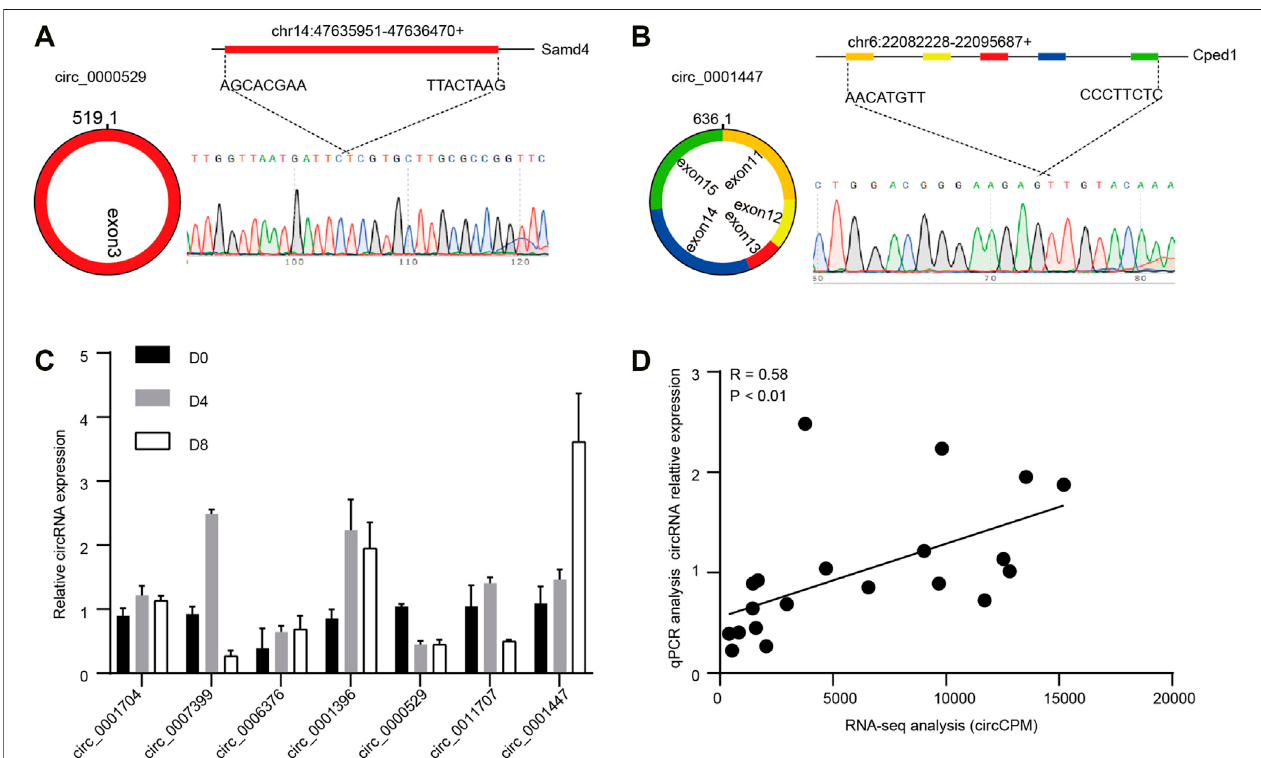
FIGURE5| Veri fi cationofcircRNAs.RepresentativecircRNAgenerationmodelsandSangersequencingresultsofcircRNAs (A) circ_0000529, (B) circ_0001447. (C) Relative circRNA expression levels were detected by qPCR. (D) Correlation analysis of RNA-seq results and qPCR results ( n (cid:1) 3).